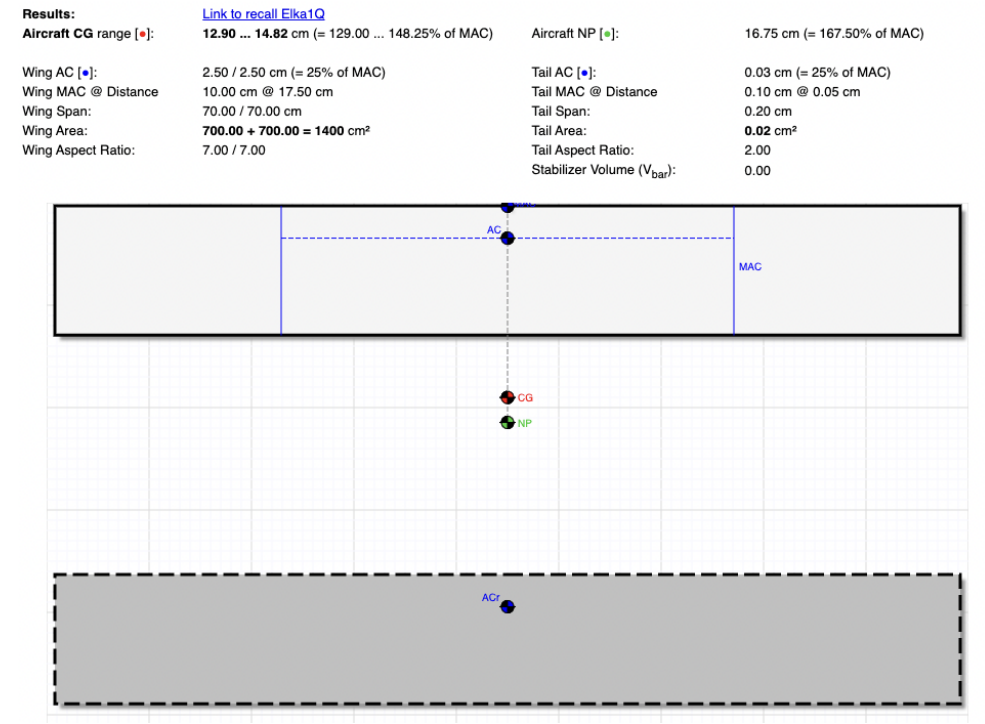
Figure 12. Centre of Gravity (CG) calculated for the Elka1Q drone by the eCalc [30] tool.